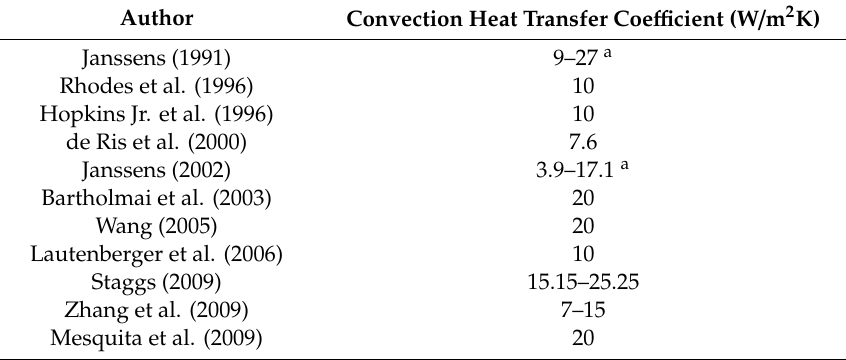
Table 2. Convective coe ffi cients used in previous studies [3,4,7,8,16–22].